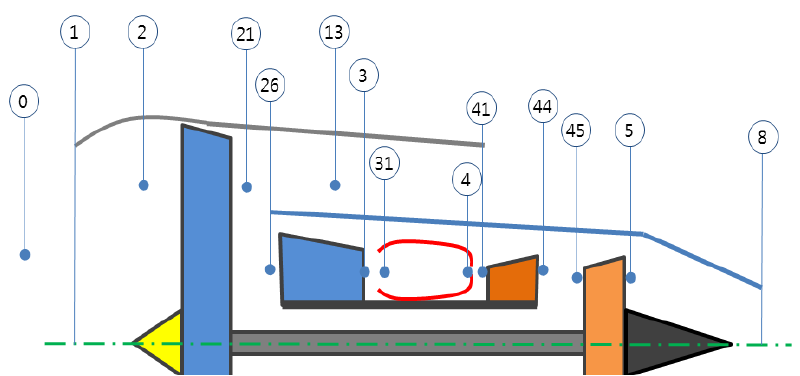
Figure 2. Station numbering for the target engine. Table 1. Specification of target engine.